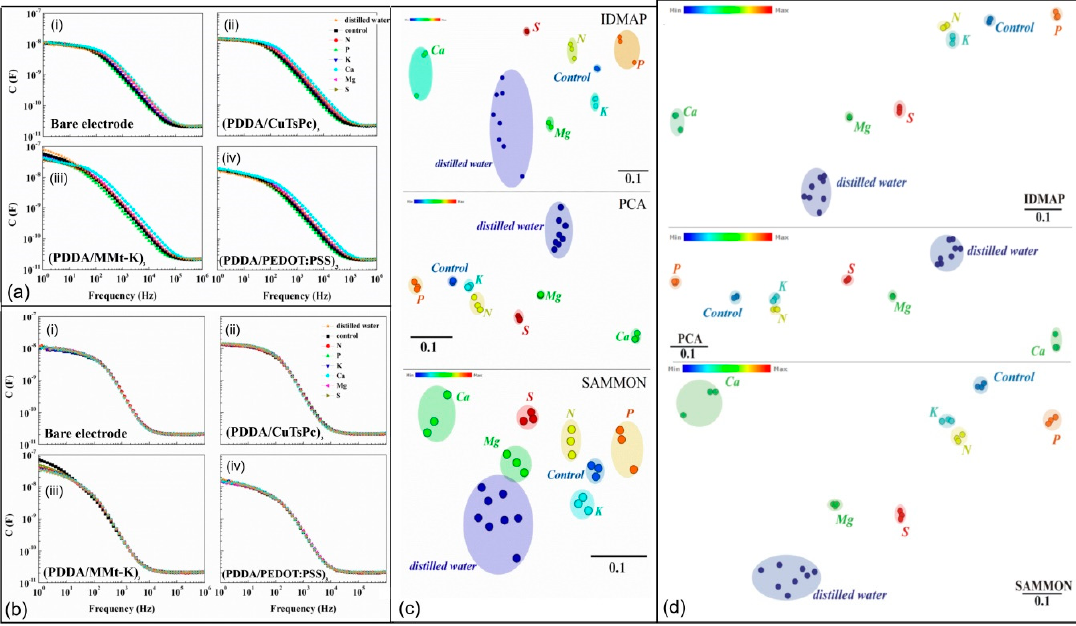
Figure 3. ( a ) Schematic of the system setup used in layer-by-layer (LbL) assembly; ( b ) cross-section view of the LbL film inside the microchannel; reprinted from [35] with permission from Elsevier (license 4684171385345); ( c ) photo of the microfluidic electronic tongue (ET) system [34] © 2017 by the authors.